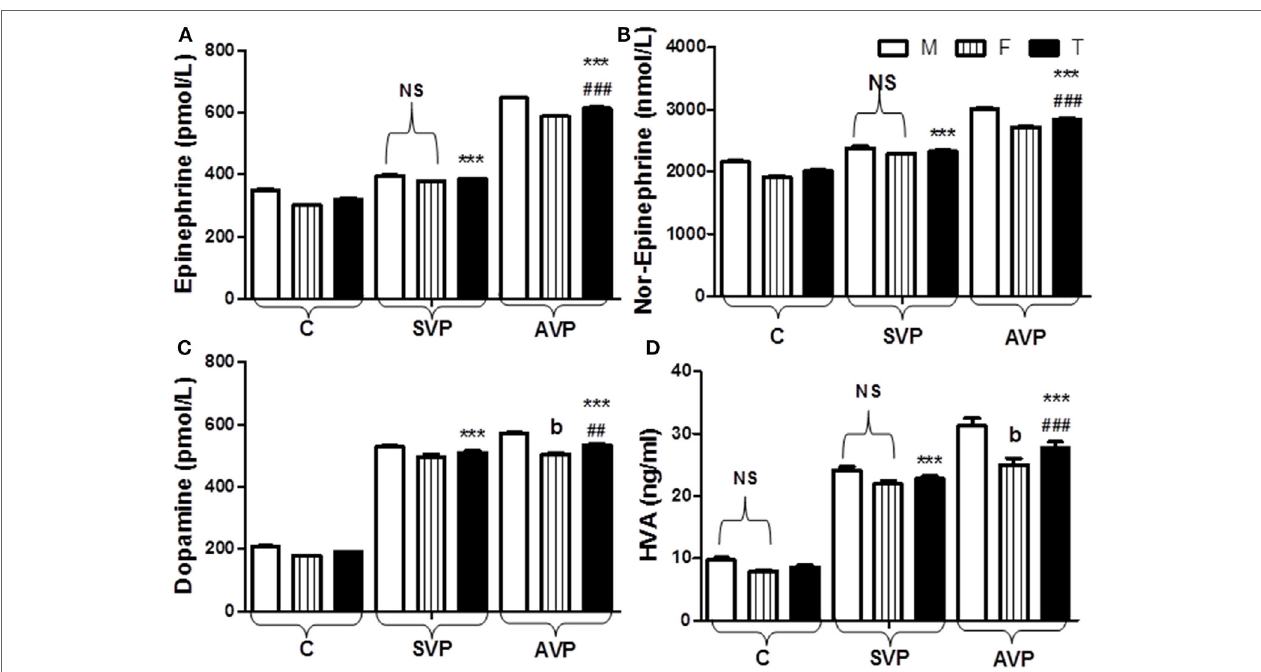
FigUre 2 | Plasma levels of epinephrine (a) , norepinephrine (B) , dopamine (c) , and HVA (D) in vitiligo patients compared with control subjects. Values are expressed as mean ± SEM. *** p < 0.001 significant vs. Control. ## p < 0.01, ### p < 0.001 significant vs. SVP, b; non-significant vs. SVP (between groups Total vs. Total; Male vs. Male; Female vs. Female). NS is a non-significant within group (Male vs. Female). Abbreviations: C, control; SVP, stable vitiligo patient; AVP, active vitiligo patient; M, male; F, female; T, total; HVA, homo-vanillic acid. FigUre 3 | Plasma levels of serotonin (a) , 5-HIAA (B) , and melatonin (c) in vitiligo patients compared with control subjects. Values expressed as mean ± SEM. *** p < 0.001 significant vs. Control. ### p < 0.001 significant vs. SVP, b; non-significant vs. SVP (between groups Total vs. Total; Male vs. Male; Female vs. Female). NS; is a non-significant within group (Male vs. Female). Abbreviations: C, control; SVP, stable vitiligo patient; AVP, active vitiligo patient; M, male; F, female; T, total; 5-HIAA, 5-hyroxyindoleacetic acid.